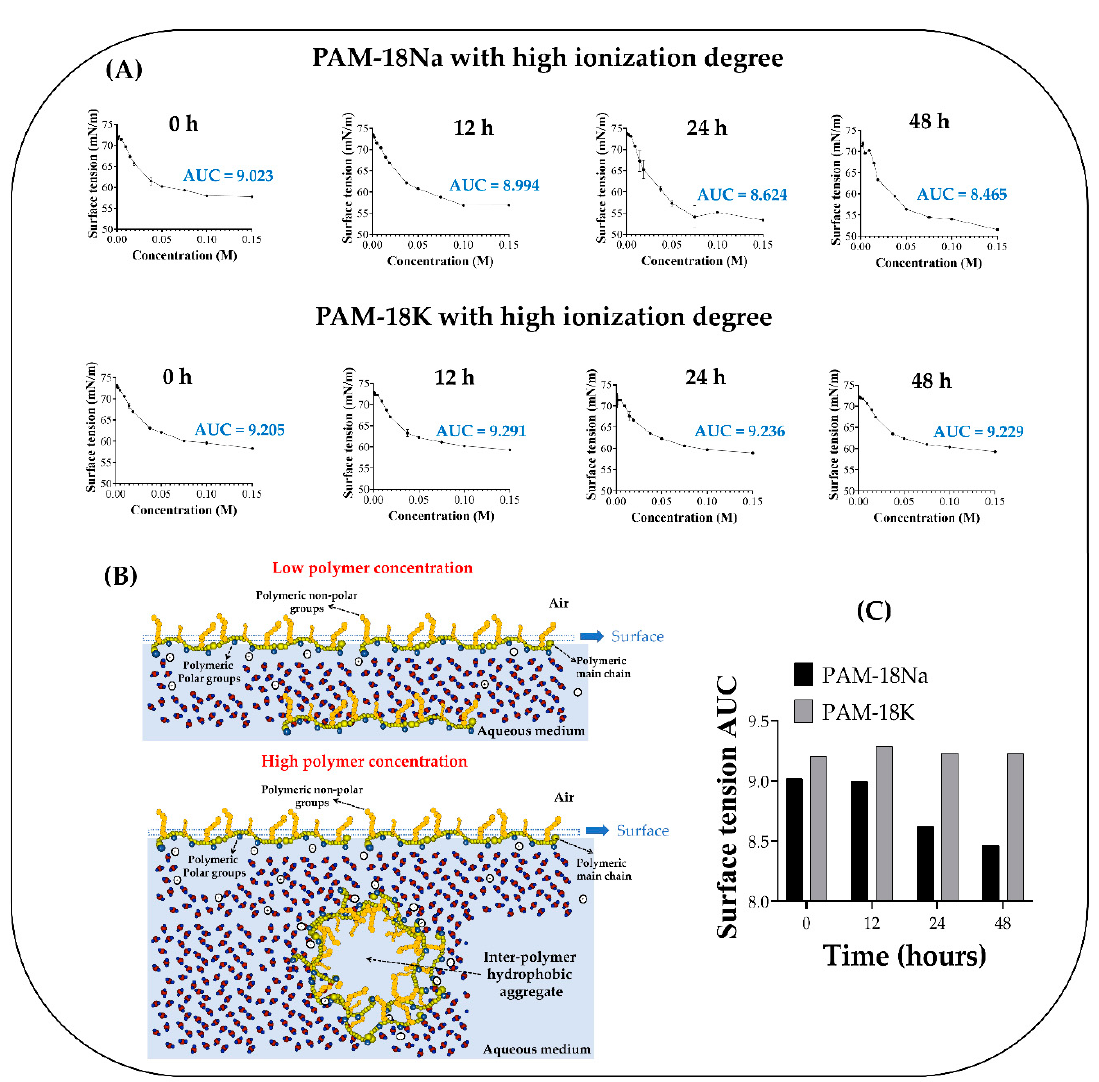
Figure 6. ( A ) Change in surface tension regarding to the concentration of PAM-18Na and PAM-18K polyelectrolytes with high ionization degree (ID) in aqueous media. ( B ) Scheme of polyelectrolyte located in the superficial zone. C ) AUC values of the surface tension vs. polymeric concentration in different times.